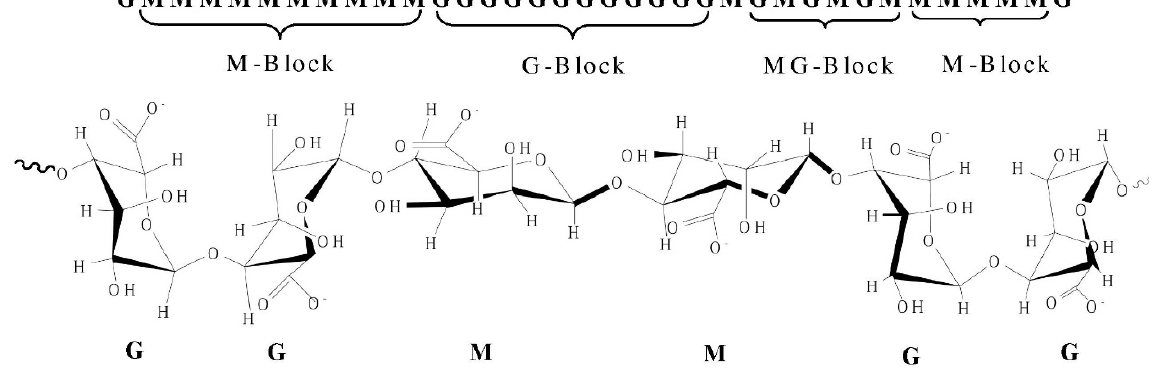
Figure 1: Alginate chain sequence and the macromolecular conformation